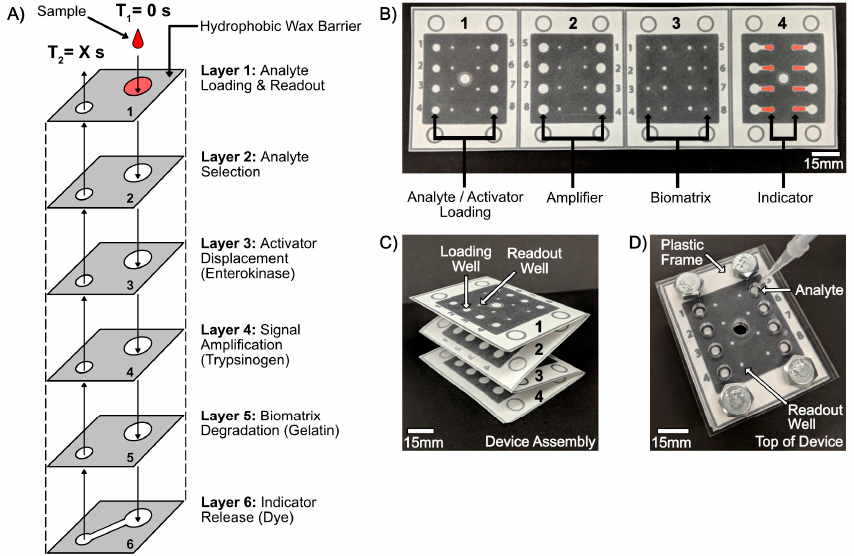
Figure 2. MicroPAD with integrated chronometric quantitation mechanism. ( A ) Schematic of the